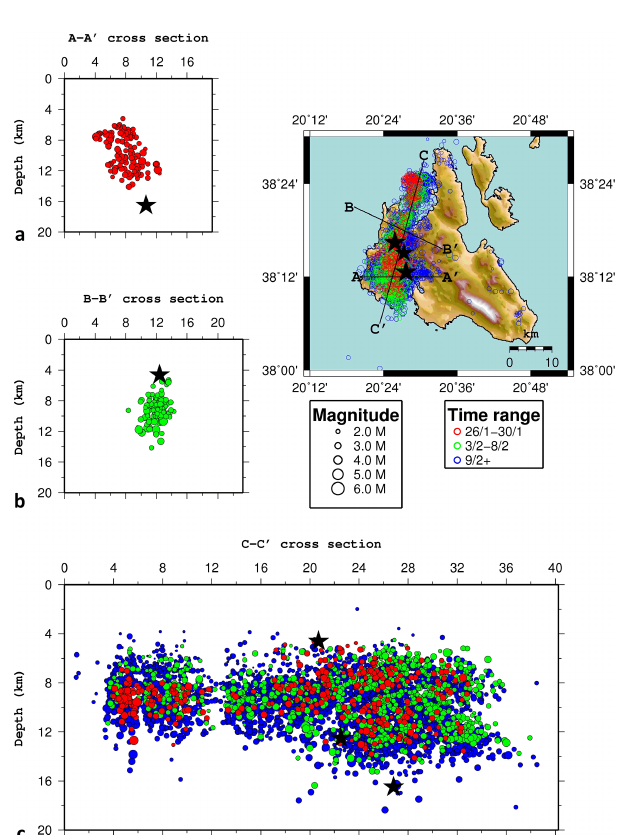
Figure 10. Vertical sections of the aftershock sequence and their lo- cation on the map: (a) the hypocenters (with GAP < 180 ◦ ) between 26 and 30 January 2014; (b) the hypocenters (with GAP < 180 ◦ ) between 3 and 8 February 2014; and (c) the hypocenters (with GAP < 180 ◦ ) for the whole sequence (26 January–15 May